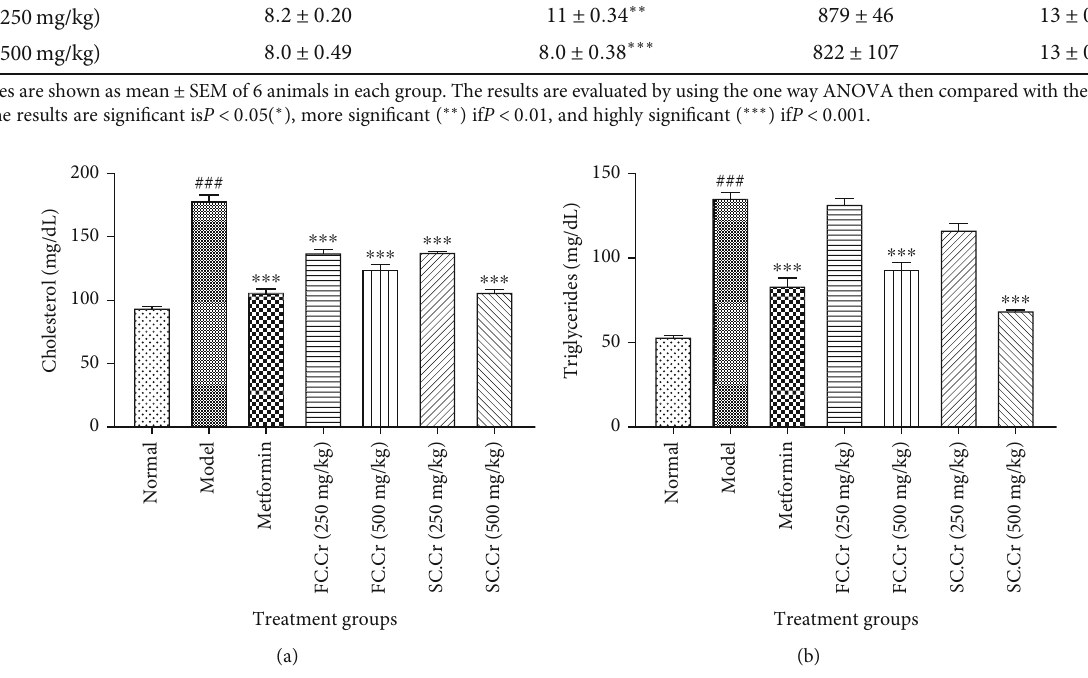
Figure 3: E ff ects of FC.Cr. and SC.Cr. on plasma levels of cholesterol (mg/dL) and TG (mg/dL) in HFD-STZ-induced rats. FC.Cr. and SC.Cr. were administered at 250mg/kg and 500 mg/kg after three weeks till the end of study duration. Cholesterol (a) and TG (b) were measured after drawing plasma from the treated and normal group of rats. The values are expressed as the mean of six animals in a group. Statistical analysis is performed with one-way ANOVA followed by Tukey ’ s test. All the groups are compared with the HFD-STZ group, while the HFD-STZ group is compared with the normal group. Results are considered signi fi cant ( ∗ ) if P < 0 : 05 ( ∗∗ ) and if P < 0 : 01 and highly signi fi cant ( ∗∗∗ ) if P < 0 : 001